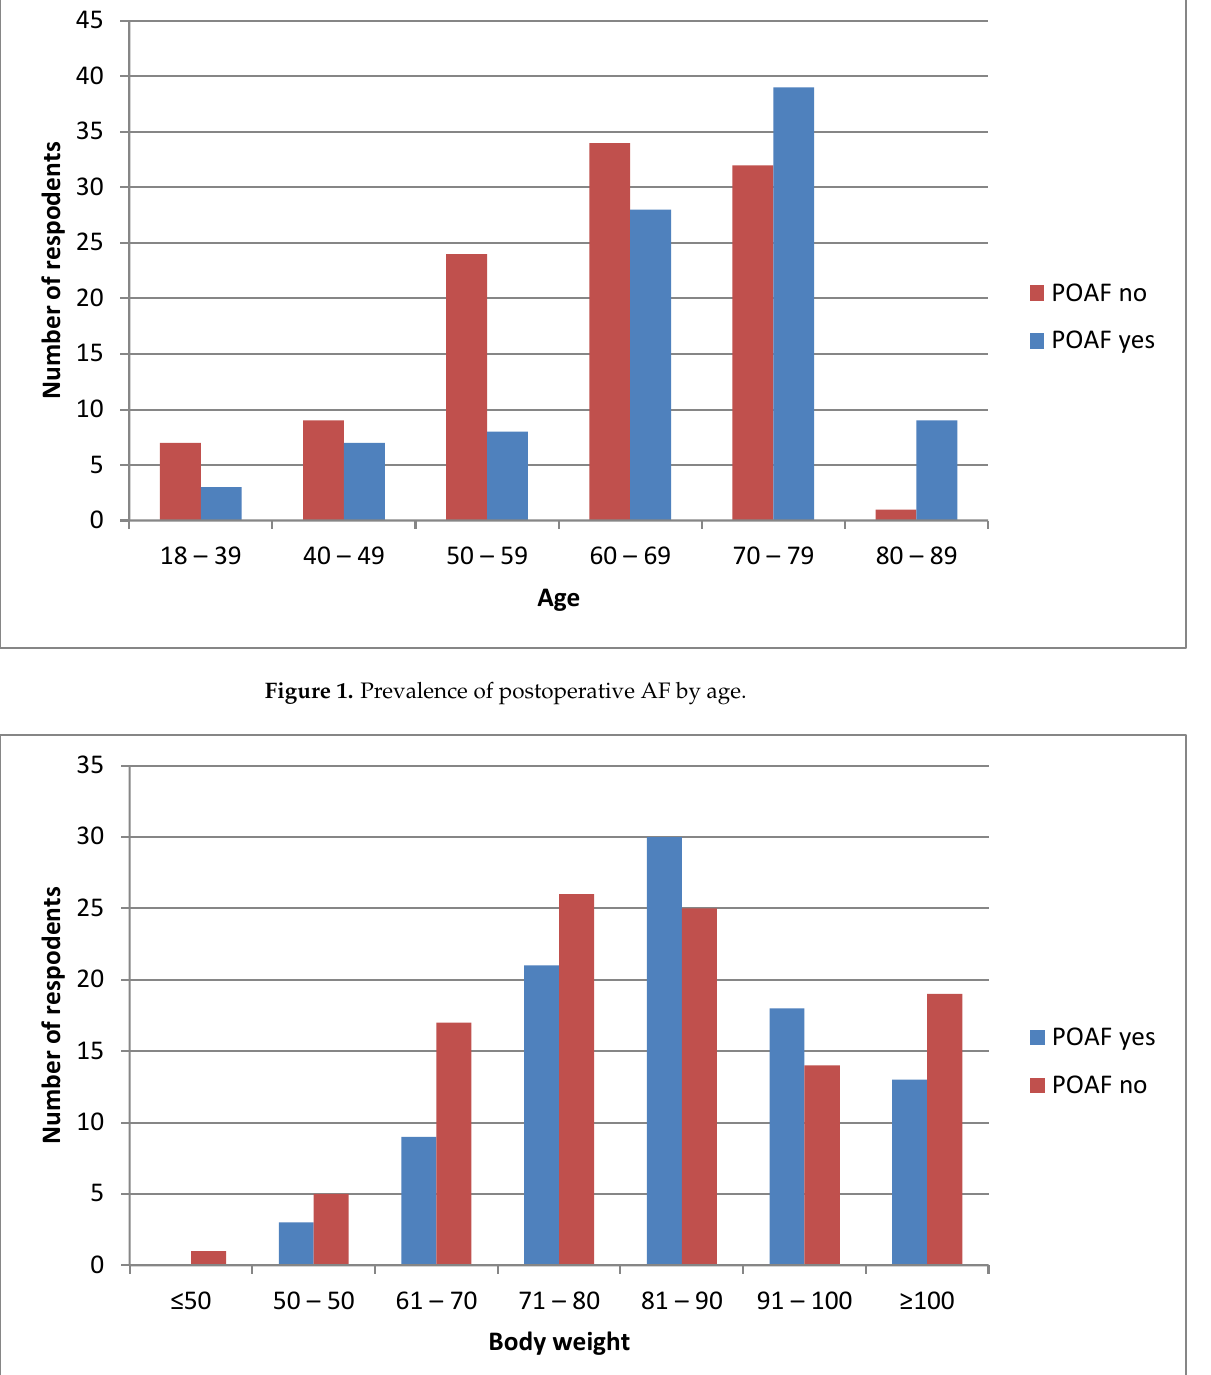
Figure 2. Prevalence of AF by body weight.